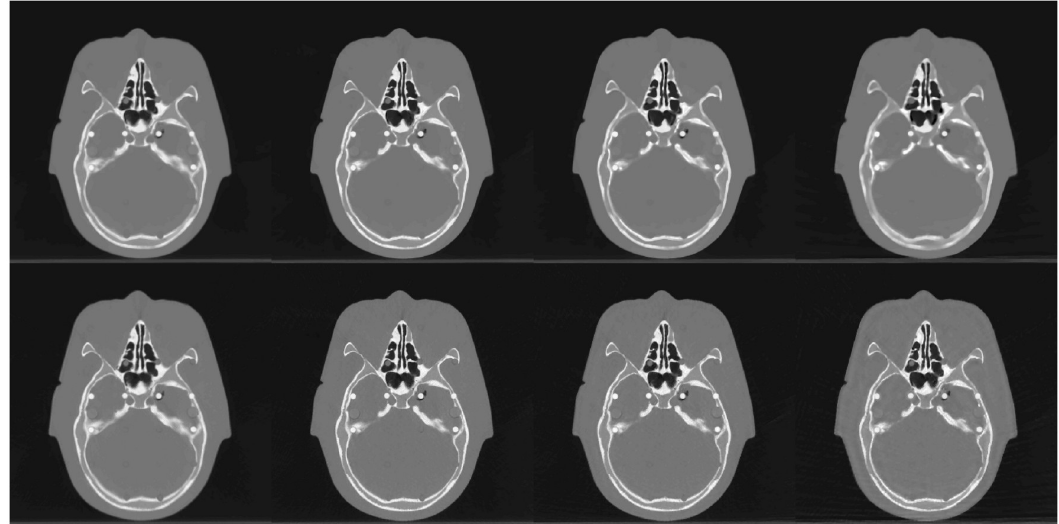
Fig 11. Visual quality comparison: TV(top row) and TF(bottom row). From left to right, reconstruction results by the sampling step size is set to 1, 4, 8, and 16. TV results shows more blurry effect compared to TF results.